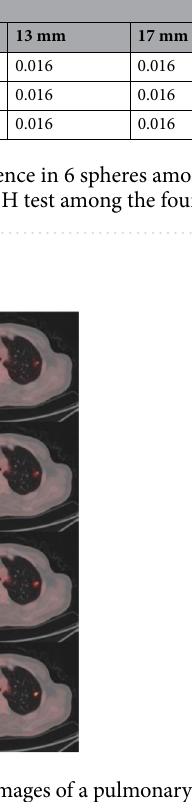
Figure 3. Illustration of PET images of a pulmonary nodule (long-axis diameter 7.2 mm) reconstructed with different algorithms. The SUVmax of OSEM, TOF, TOF-PSF, Q.Clear reconstructed images were 1.93, 2.62, 3.9, 7.28 respectively. The SUVmean were 0.99, 1.42, 1.87, 3.46 respectively. All the PET images are displayed on SUV scale 0–8.